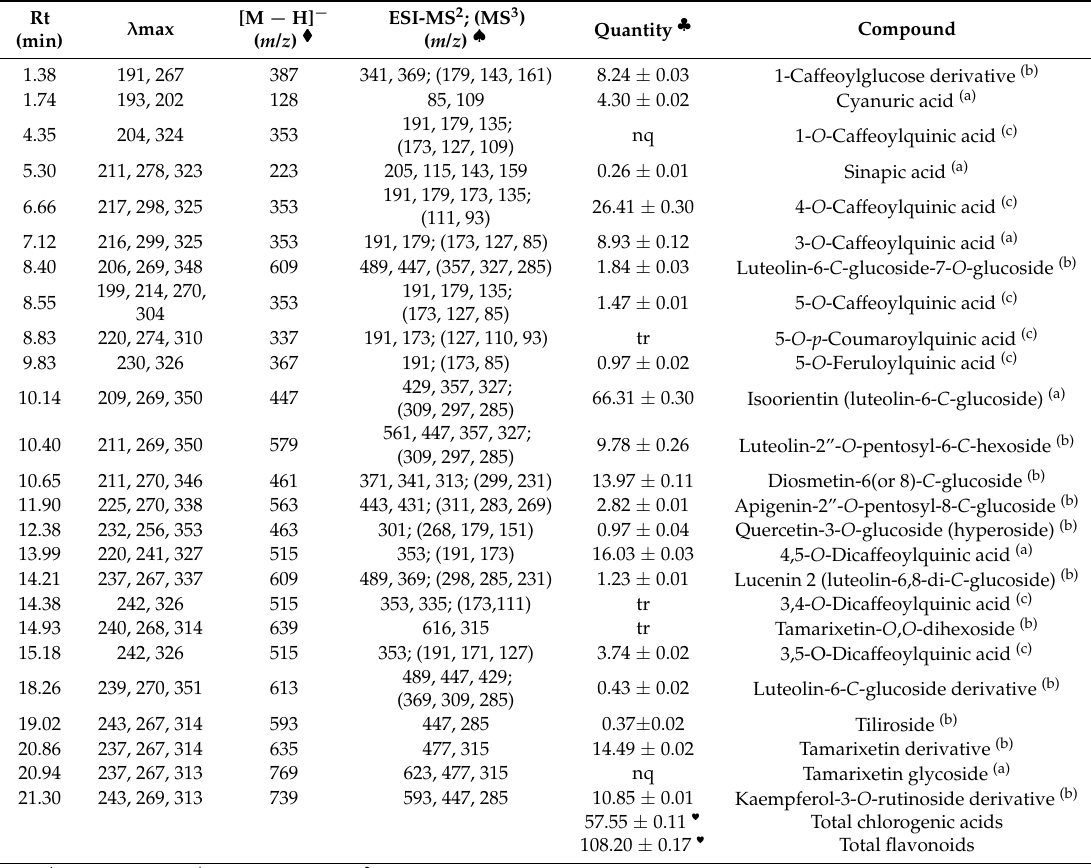
Table 2. Identification of UHPLC/DAD/ESI-MS n data, and quantification of the most relevant compounds from the ethanolic extract of S. stellata (Retention time (Rt), wavelength of maximum absorption in the UV-Vis region ( λ max), pseudomolecular and MS n fragment ions, quantification (mean ± SD) and identification of the phenolic compounds).